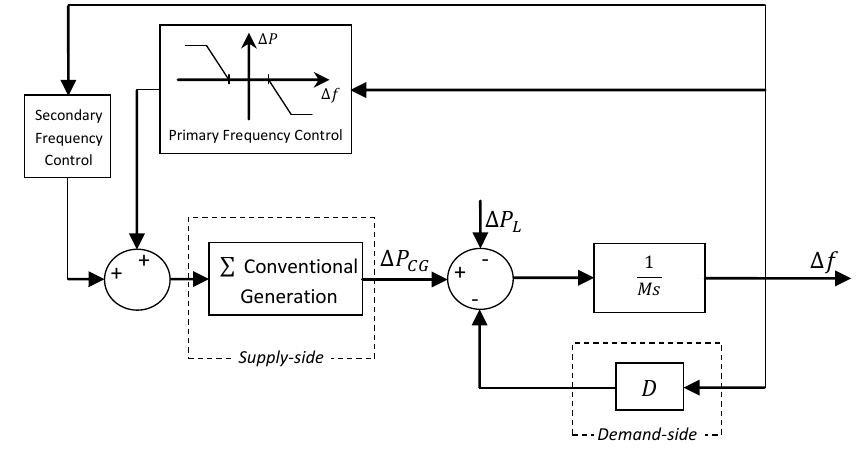
Figure 1. General scheme of a power